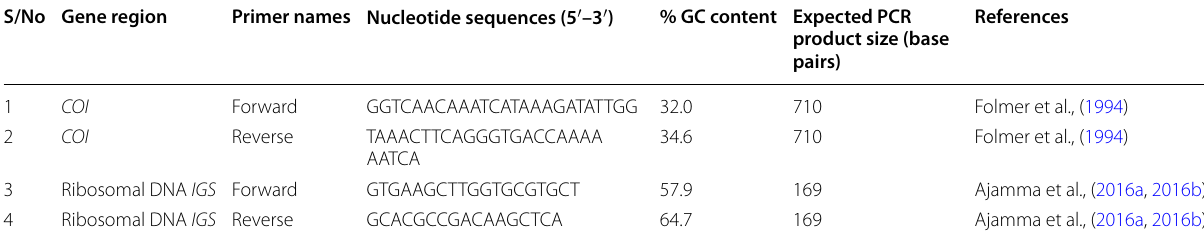
Table 1 Primer sequences from COI and IGS sequences used for detection of polymorphism in the Mosquito populations S/No Gene